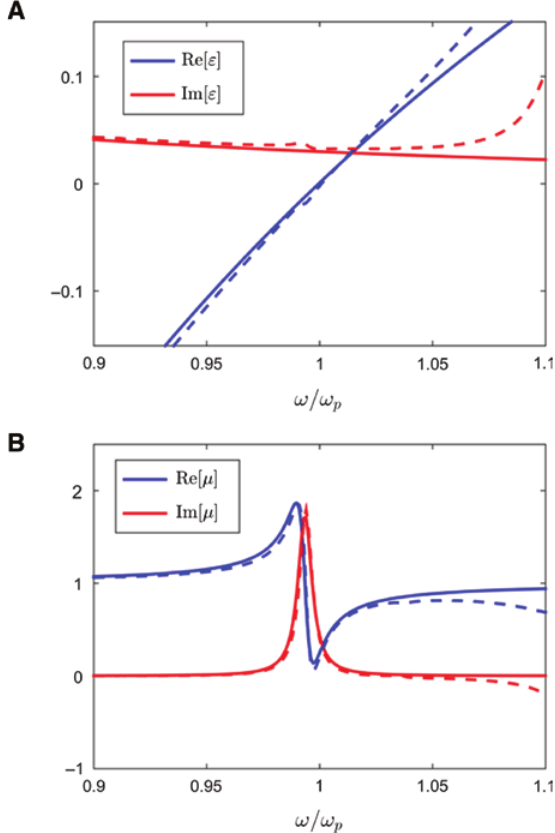
Figure 2: Comparison between the effective (A) permittivity and (B) permeability, obtained via numerical parameter extraction from the reflection/transmission coefficients (dashed), and their theo- retical values